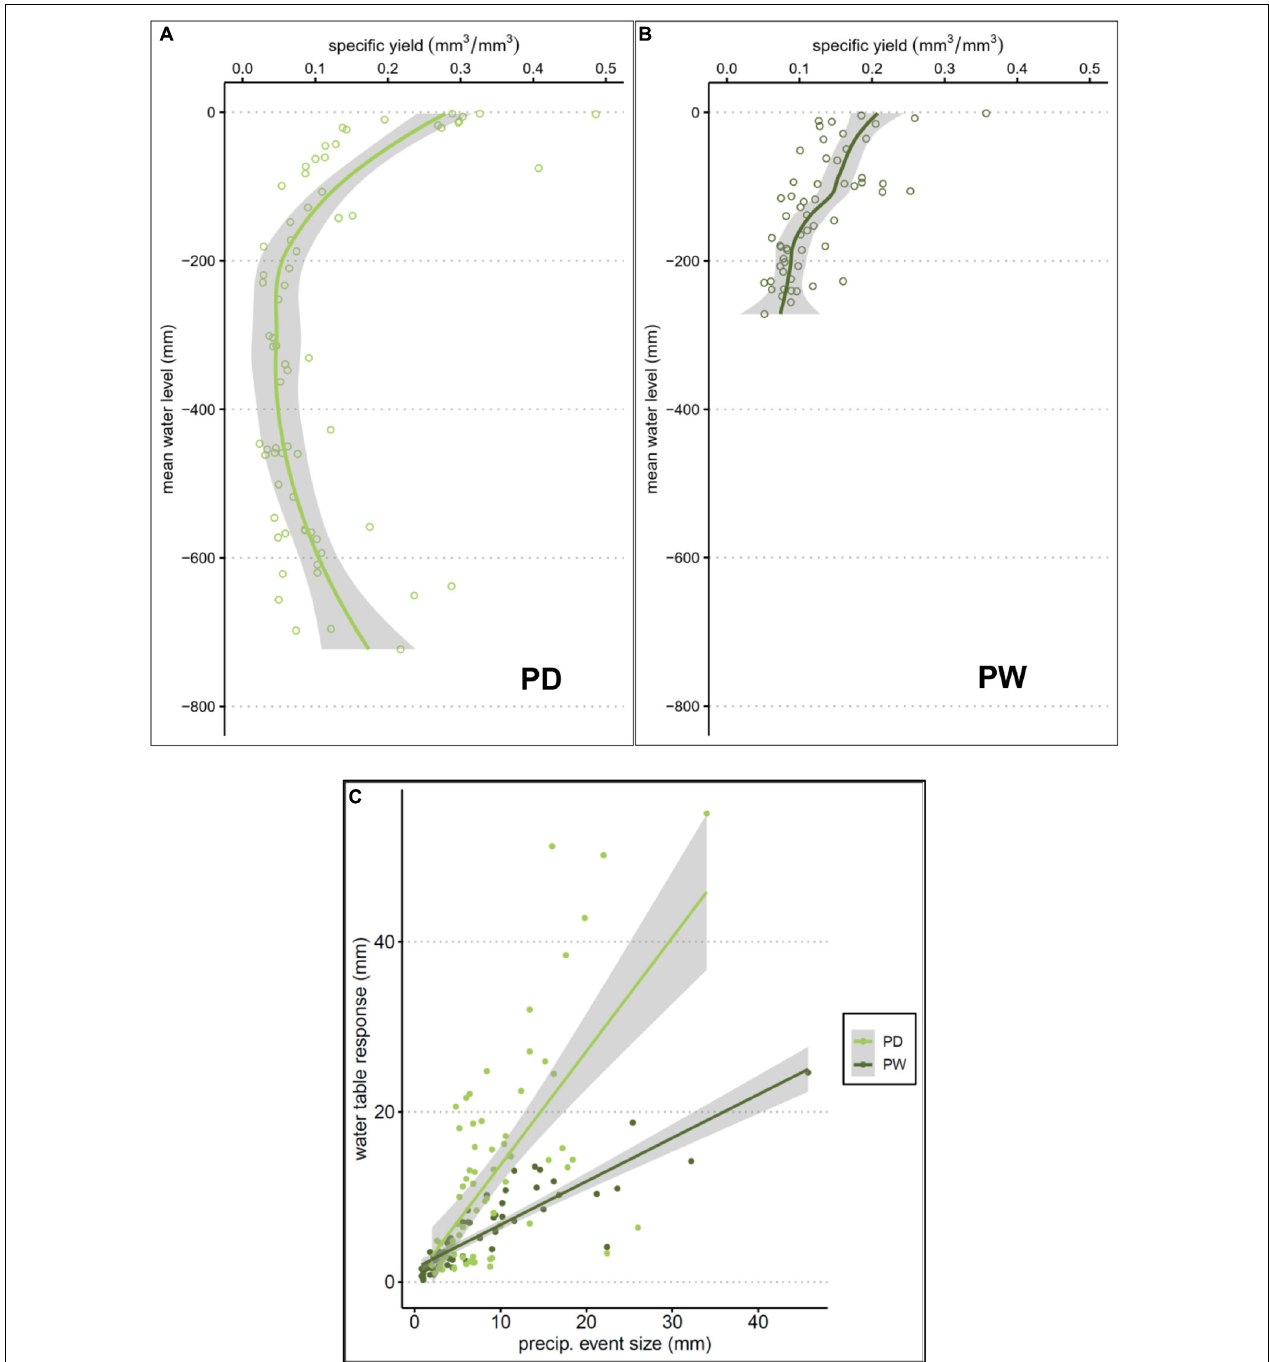
FIGURE 3 | Soil specific yield determined as the precipitation event size (mm) to groundwater table response ratio (P re : (cid:49) GWL) according to mean water level for (A) PD and (B) PW. The solid lines represent the loess smoothing function and the shaded area represents the 95% confidence interval. (C) water table response to precipitation event size for both PD and